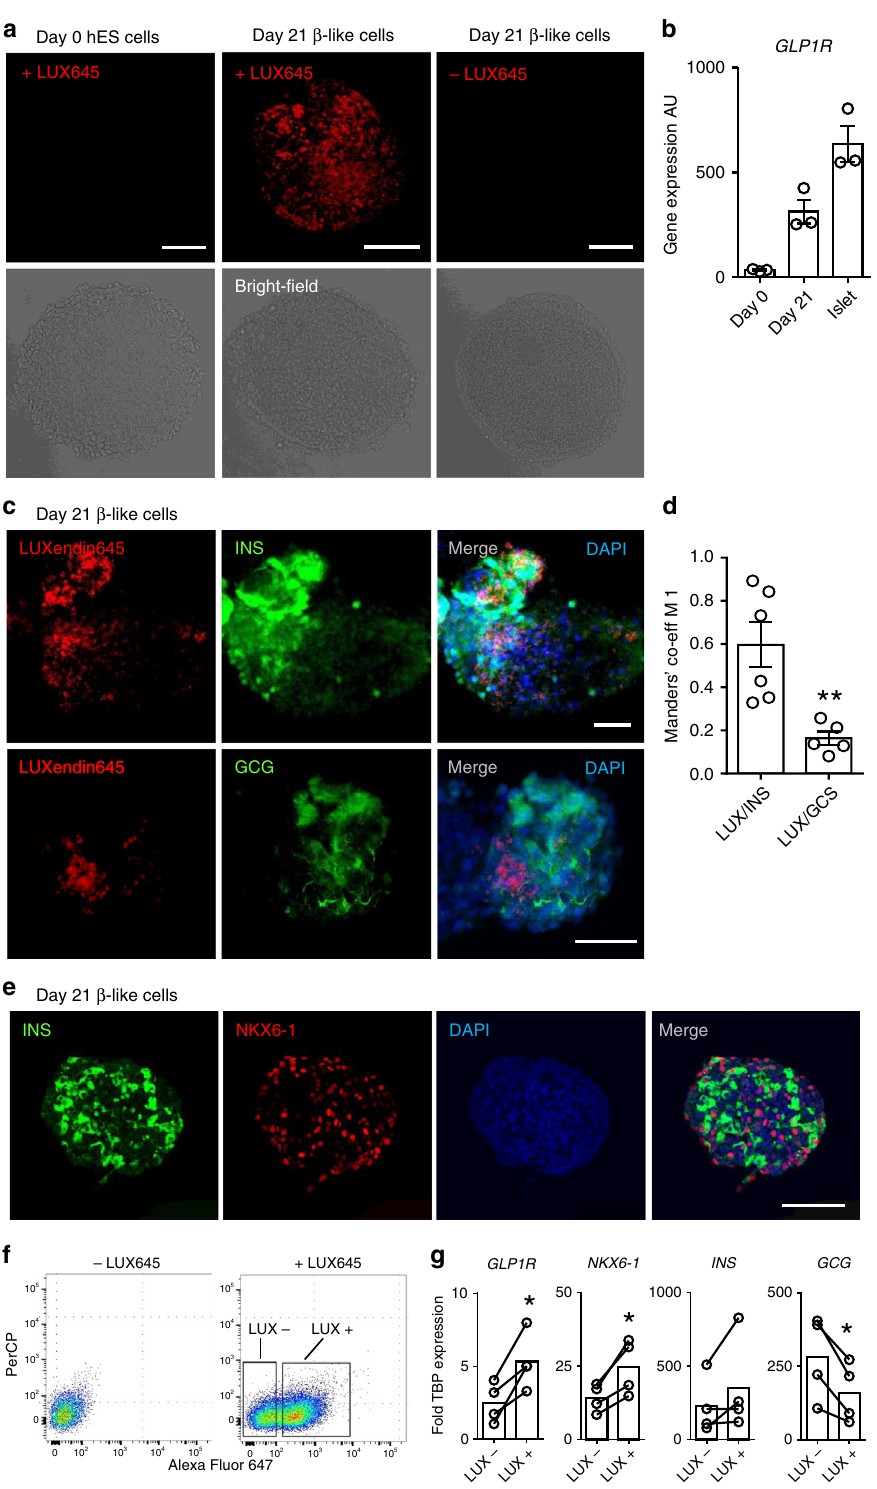
with Glp1r forward primer 5 ′ -CAGGCGCTCAGAGCTAGAAGC-3 ′ and with Glp1r wild-type reverse primer 5 ′ -CCAGGGCTCACCTGAGGG-3 ′ or Glp1r knockout 5 ′ -CCAGGGCTCACCTGAGGC-3 ′ to amplify and detect the WT or mutant allele, respectively. Animals were bred as heterozygous pairs to ensure Glp1r + / + littermates. Glp1r (GE) − / − animals are freely available for academic use, subject to a Material Transfer Agreement. Ins1Cre Thor ;R26 mT/mG : To allow identi fi cation of β - and non- β -cells, Ins1Cre Thor animals with Cre knocked-in at the Ins1 locus (strain B6(Cg)- Ins1 tm1.1(cre)Thor /J; JAX stock no. 026801) were crossed with R26 mT/mG reporter mice (strain B6.129 (Cg)- Gt(ROSA)26Sor tm4(ACTB-tdTomato,-EGFP)Luo /J; JAX stock no. 007676). Cre-